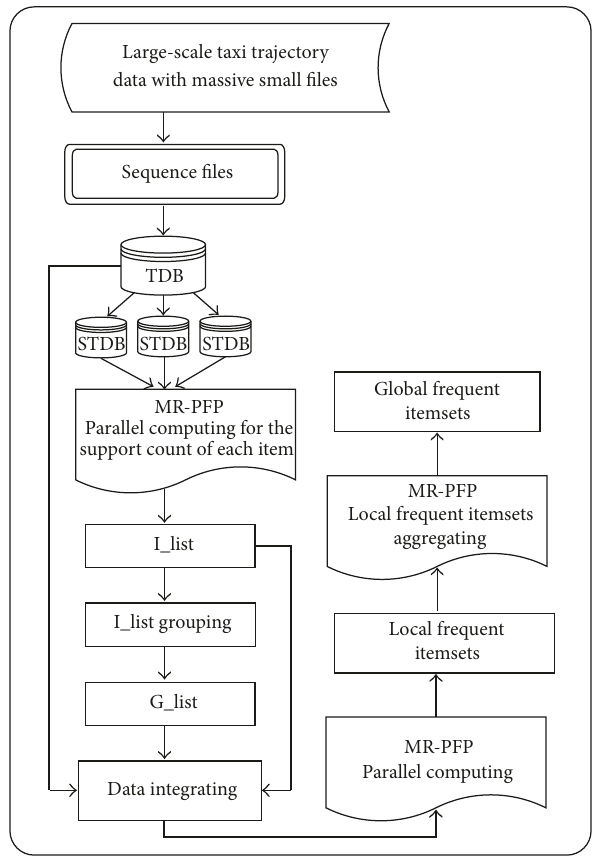
Figure 2: The flowchart of the MR-PFP algorithm.